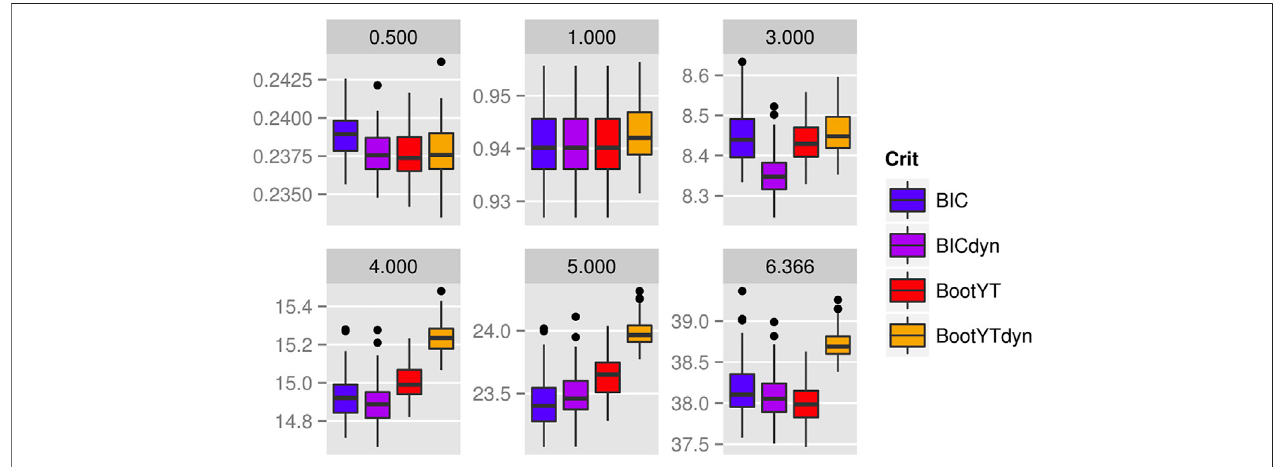
FIGURE 2 | Boxplots of 10-CV MSE based on y with